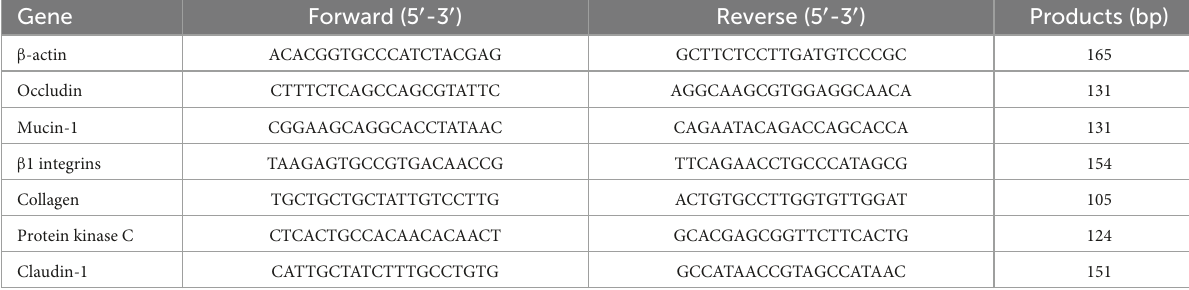
TABLE 2 Primers used for quantitative real-time PCR (RT-PCR). Gene Forward (5 (cid:48) -3 (cid:48) ) Reverse (5 (cid:48) -3 (cid:48)